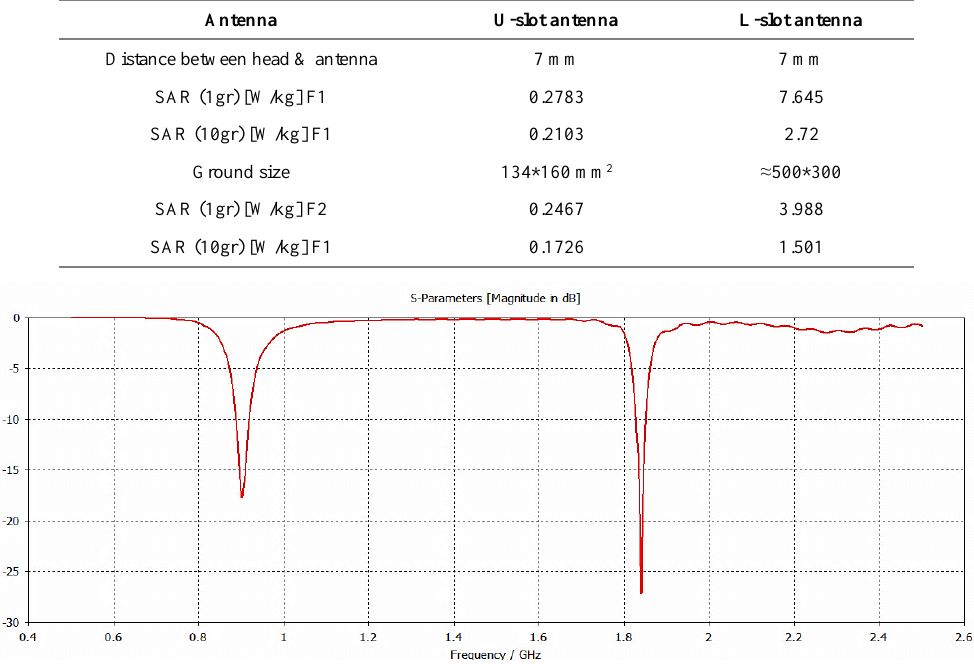
Figure 20. The return loss of antenna with head